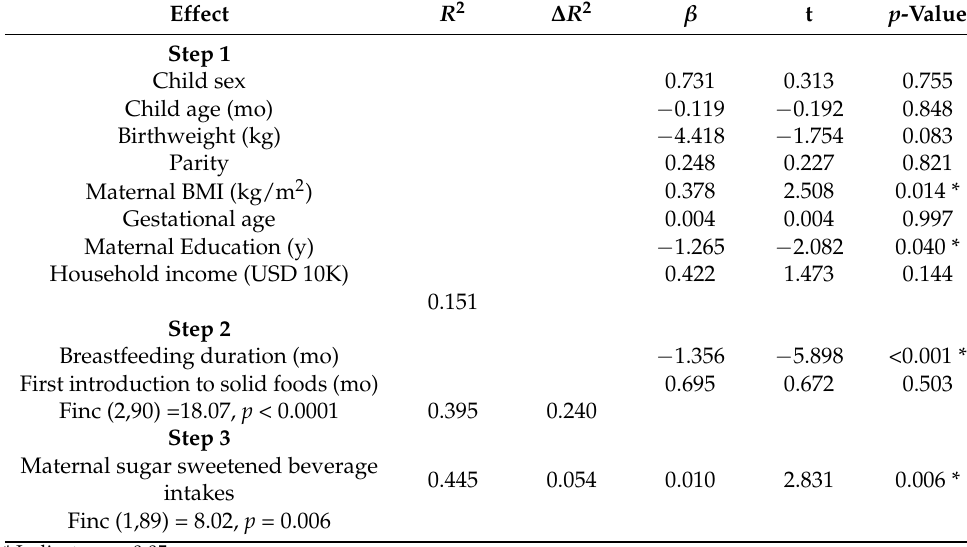
Table 3. Hierarchical regression model of maternal sugar sweetened beverage intakes ( R 2 , change statistics [ ∆ R 2 ], and regression coefficients [ β ]) predicting infant added sugar intakes ( n =